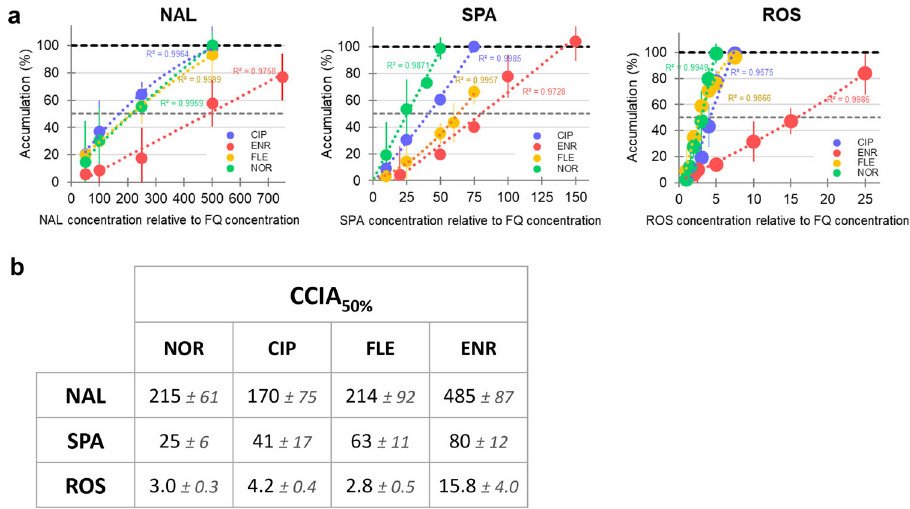
Fig. 2 CPTs concentrations needed to increase FQ accumulation by 50%. a Increasing FQ accumulation rate (%) as a function of the co-incubated CPT concentrations. FQs accumulation % (± SD) were calculated from the data shown in Fig. 1 where the FQ accumulation measured without CPT in the absence and in the presence of CCCP correspond to 0% and 100%, respectively. b CPTs Concentrations needed to Increase Accumulation of FQ by 50% compared to CCCP (CCIA 50 ), calculated from the trend curve (degree 2 polynomial) plotted in a